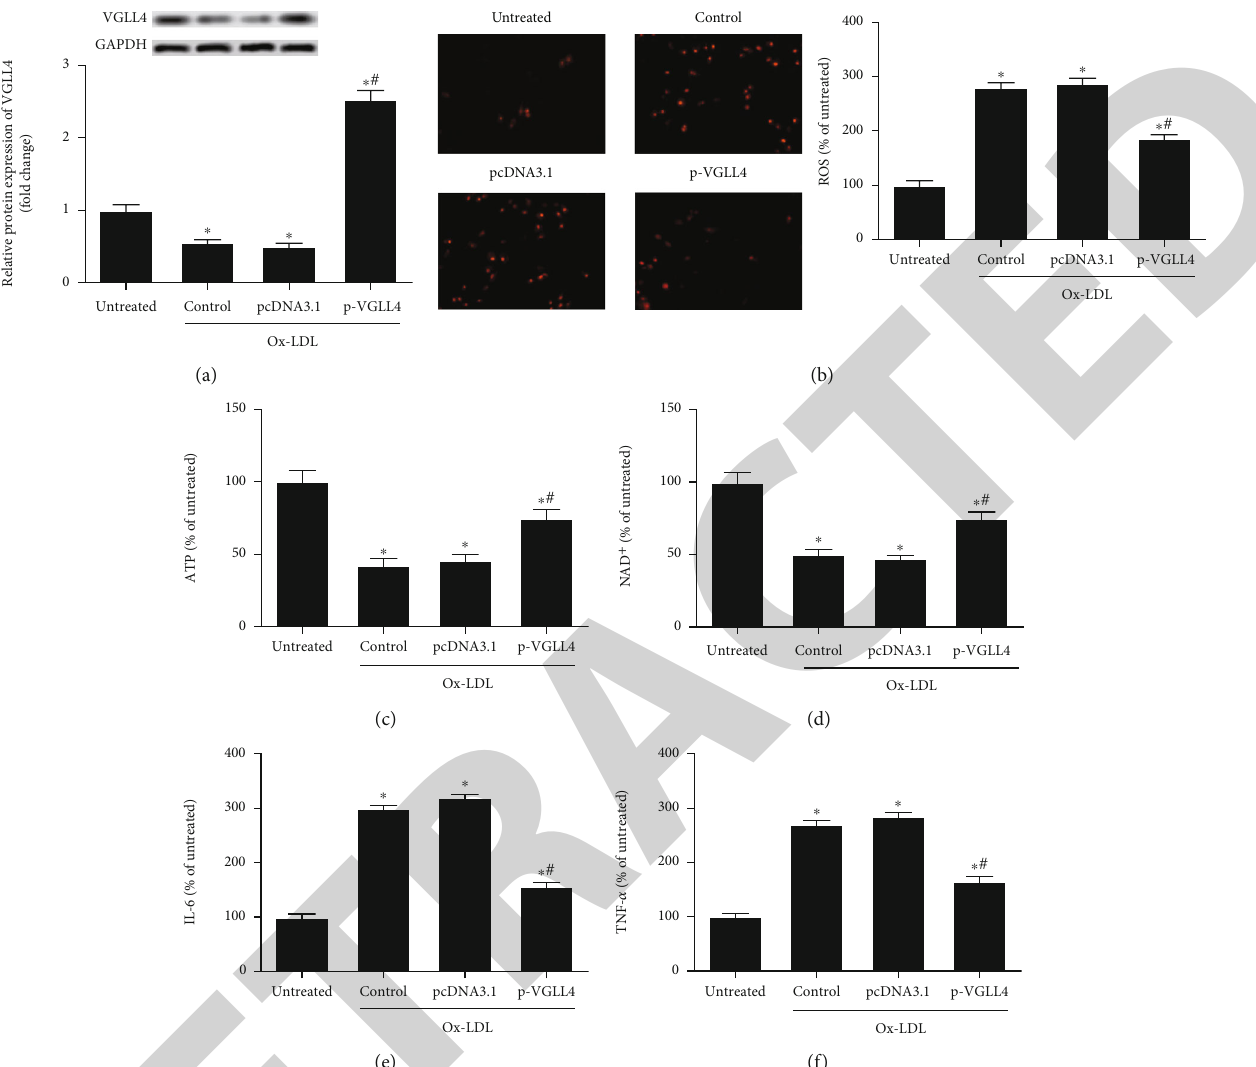
Figure 2: Overexpression of VGLL4 alleviates Ox-LDL-induced oxidative stress and in fl ammation in HUVECs. The HUVECs were treated with Ox-LDL (100 μ g/mL) and transfected with the control vector (pcDNA3.1 group) or pcDNA3.1-VGLL4 (p-VGLL4 group), respectively. (a) The protein expression of VGLL4 in the untreated, control, pcDNA3.1, and p-VGLL4 groups. (b) The ROS level in the untreated, control, pcDNA3.1, and p-VGLL4 groups. (c) The NAD + level in the untreated, control, pcDNA3.1, and p-VGLL4 groups. (d) The ATP level in the untreated, control, pcDNA3.1, and p-VGLL4 groups. (e) The IL-6 level in the untreated, control, pcDNA3.1, and p-VGLL4 groups. (f) The TNF- α level in the untreated, control, pcDNA3.1, and p-VGLL4 groups. “ ∗ ” means compared with the untreated group at P < 0 : 05 , and “ # ” means compared with the pcDNA3.1 group at P < 0 : 05 . GAPDH was used as an invariant internal control for calculating protein fold